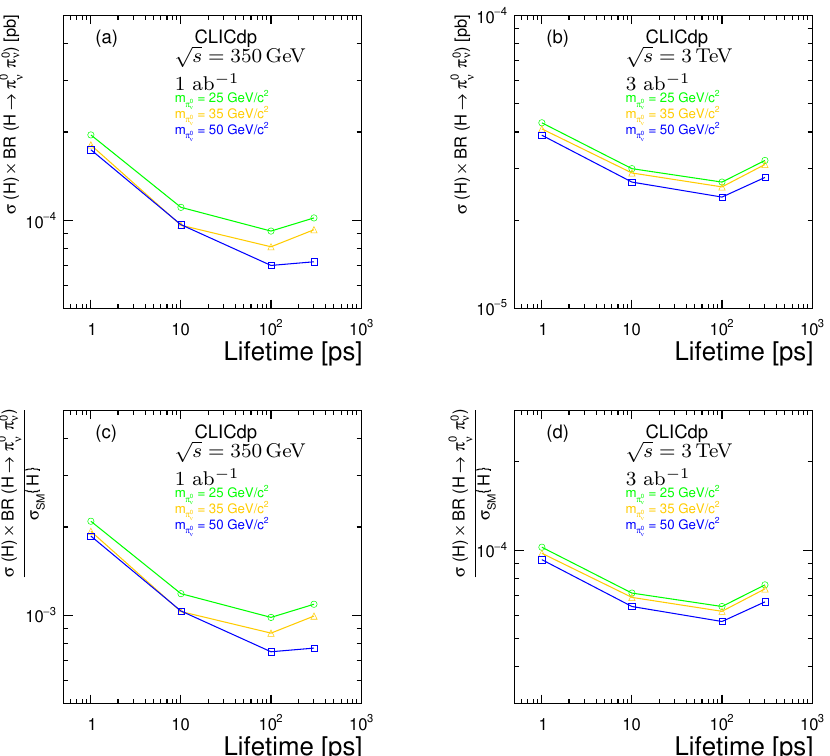
Figure 7 . Expected 95% CL cross-section upper limits on the σ ( H ) × BR ( H → π 0 model [2], for three different π 0 masses: 25 GeV/c 2 (green), 35 GeV/c 2 (yellow), 50 GeV/c 2 (blue), v √ as a function of π 0 lifetime for s = 350 GeV (a) and v the upper limits normalised to the Standard Model production cross-section of the Higgs boson at √ √ s = 350 GeV (c) and s = 3 TeV (d). An integrated luminosity of 1 ab − 1 at √ 3 ab − 1 at s = 3 TeV has been